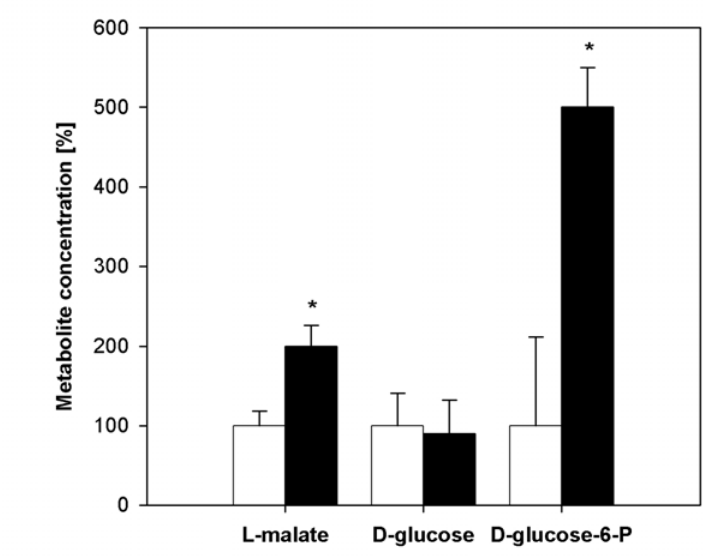
Figure 7. Concentrations of important cell metabolites. Measurement of concentrations of L -malate, D -glucose and D -glucose-6-phosphate in Nicotiana tabacum L. leaves of healthy plants and those infected by PVY NTN . Relative concentrations (expressed as % of healthy controls) are presented ( L -malate: 100% corresponds to 10.5 mmol·g -1 F.W.; D -glucose: 100% corresponds to 2.8 mmol·g -1 100% means 0.06 mmol·g -1 F.W.)